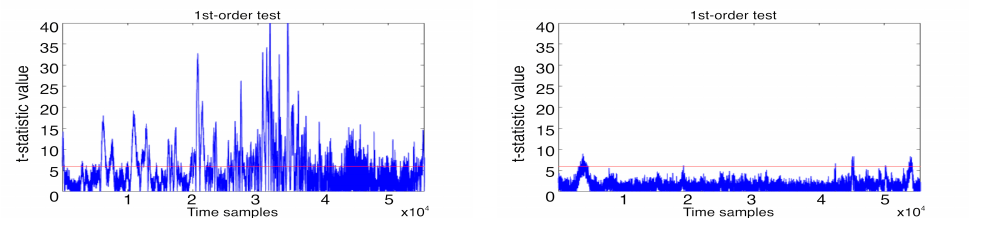
Figure 18: unprotected_new_curve () rdm vs fixed point